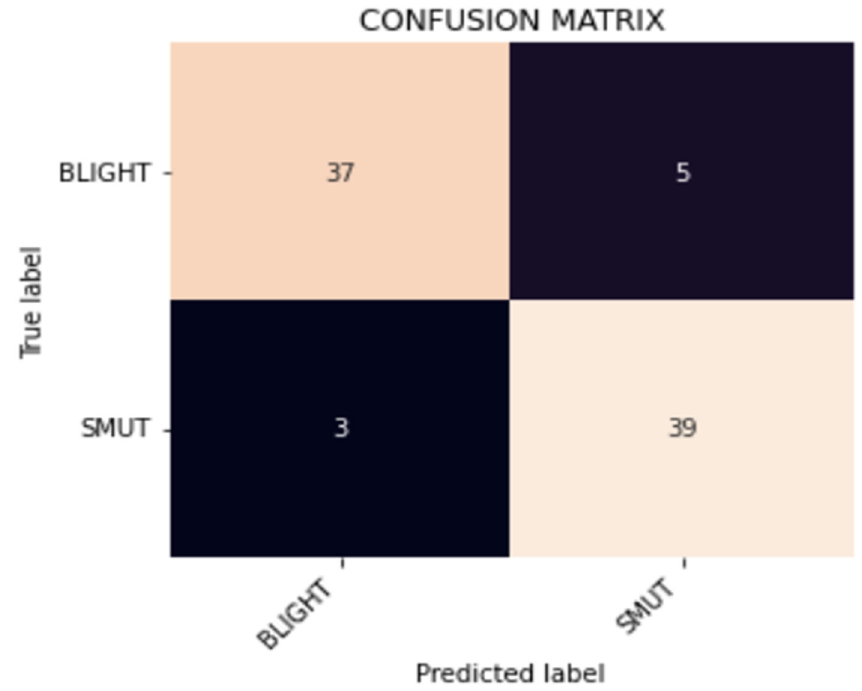
Figure 13. Confusion Matrix For Trained Model.